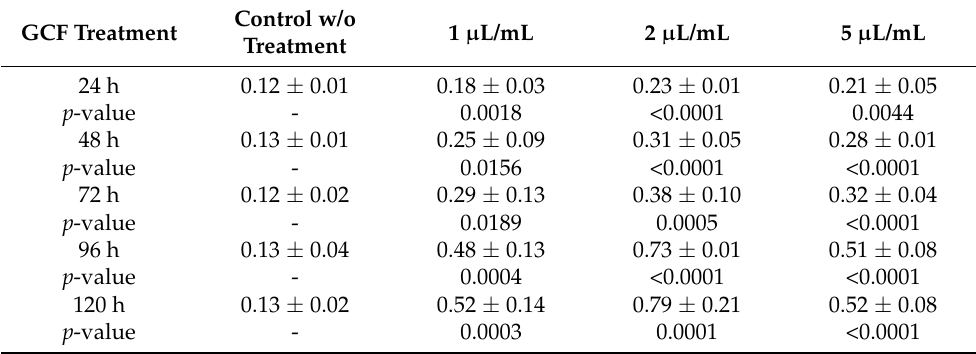
Table 4. Relative gene expression of TIM-3 in CD3+ T lymphocytes treated with different concentra- tions of GCF (Mean ± SD).